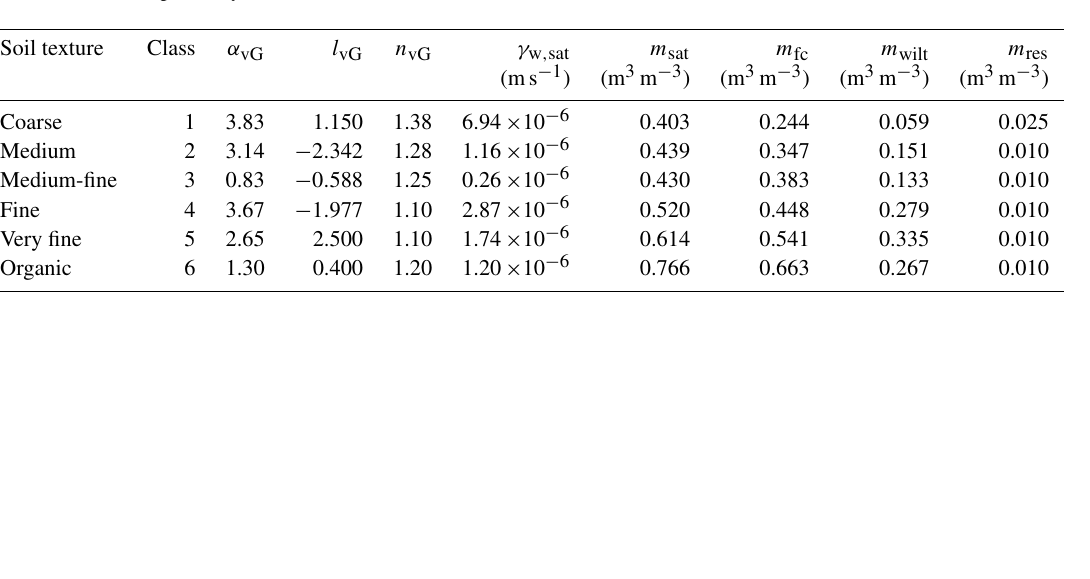
Table A6. Soil classification parameters according to soil_type . α vG , l vG and n vG are van Genuchten parameters, γ w , sat is the hydraulic conductivity at saturation, and m sat , m fc , m wilt , and m res are the volumetric soil moisture at saturation, at field capacity, at wilting point, and the residual soil moisture,